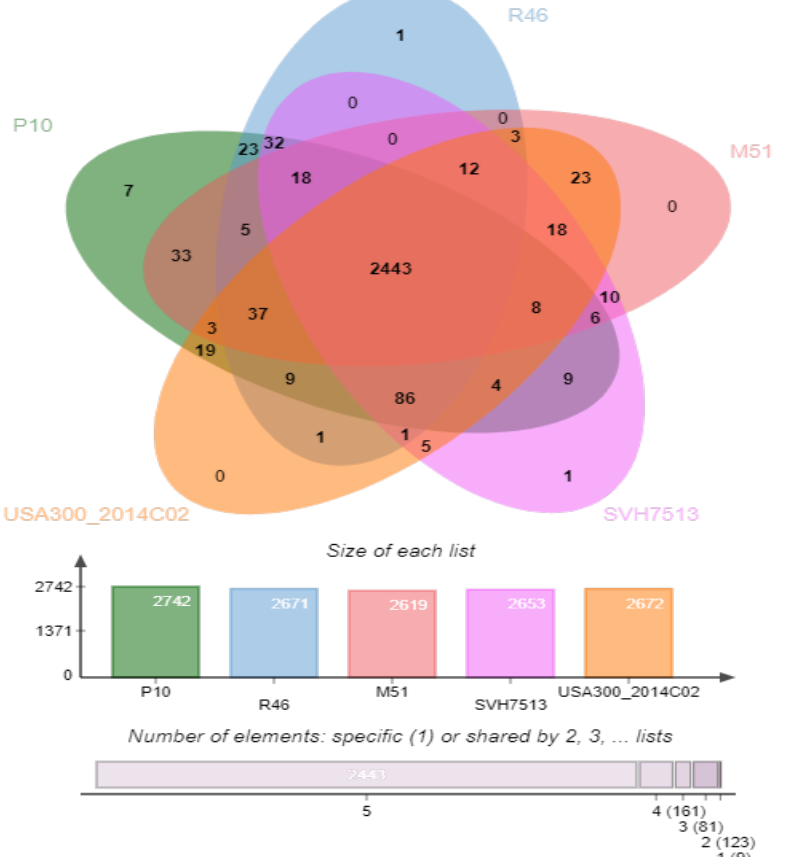
Figure 4. Comparison of clusters of orthologous groups (COGs) of P10 and R46 with their phyloge- netically related strains M51 ST1516, SVH7513 ST612, and USA300_2014.C02 ST8. The Venn diagram represents the numbers of unique and shared COGs, while the bar chart represents the number of clusters in each strain.